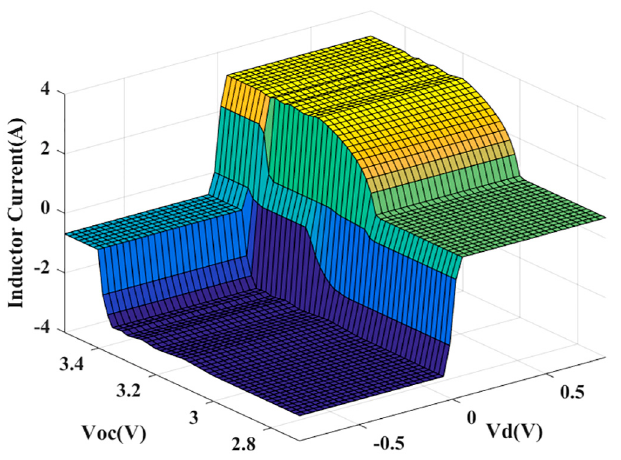
Figure 11. Inductor current with input